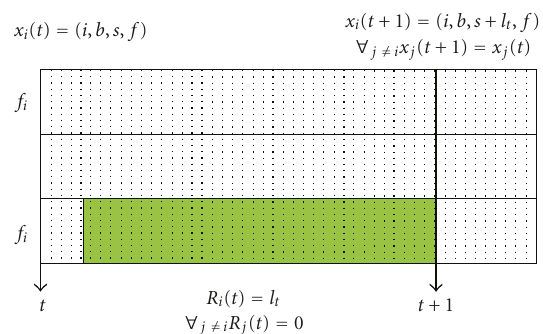
Figure 7: The dynamics of the problem are as such that when using a channel, its state is updated while the state of all other channels remain